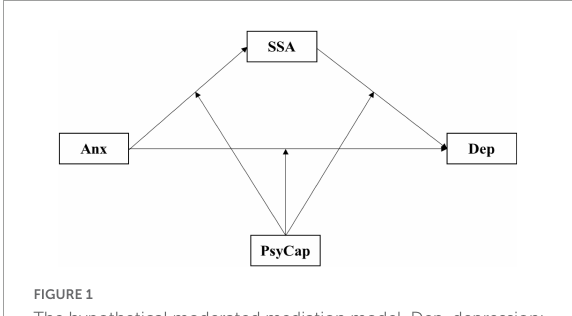
FIGURE1 The hypothetical moderated mediation model. Dep, depression; Anx, anxiety; SSA, social support availability; PsyCap, psychological capital.